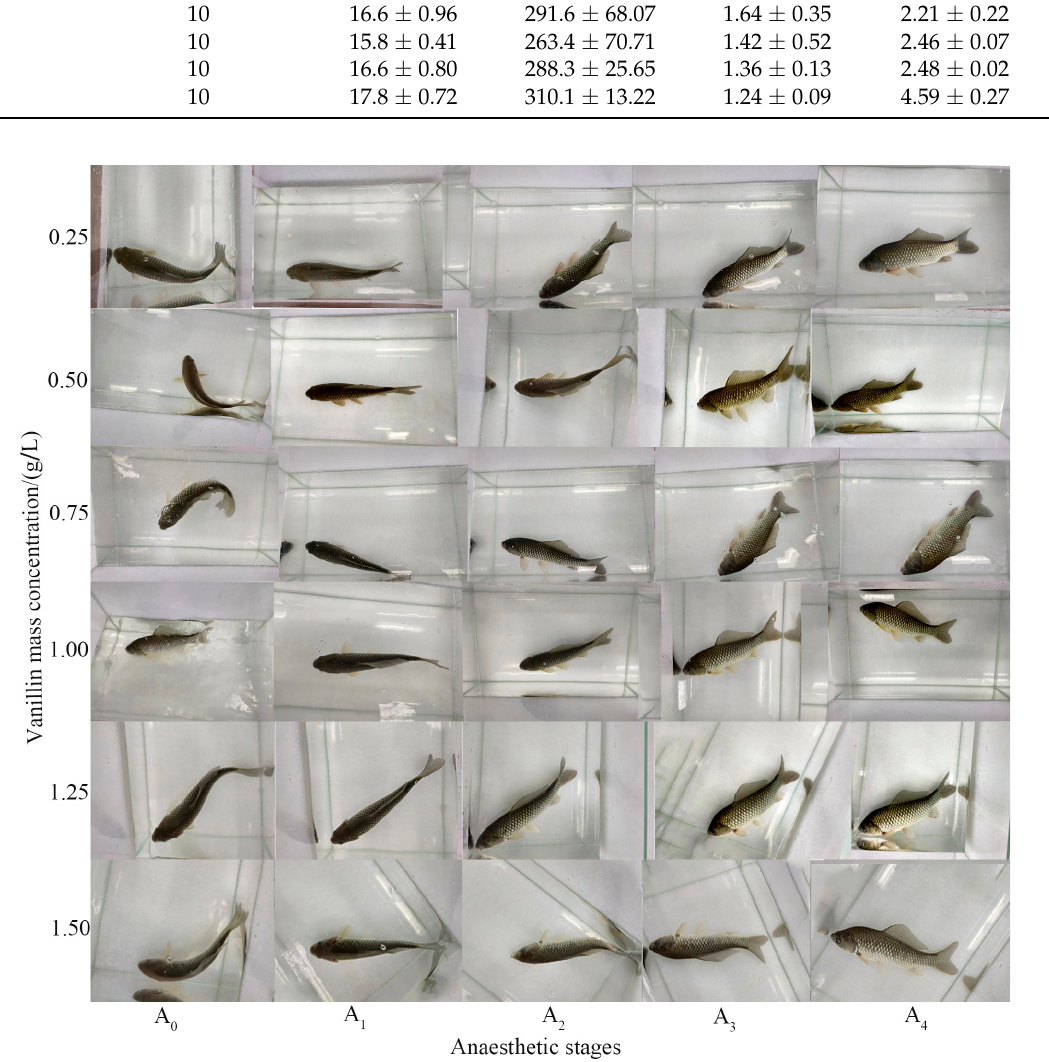
Figure 1. Appearance of crucian carp at the five stages of anaesthesia. Behavioural Characteristics of Crucian Carp during the Five Stages of Anaesthesia Onset and the Four Stages of Recovery The timing and behavioural characteristics at each stage of anaesthesia (A 0 –A 4 ) and recovery (R 1 –R 4 ) of crucian carp were determined using 1.00 g/L vanillin (Table 3). When a fish stopped swimming, completely lost the ability to respond, and the operculum opened weakly and slowly, it was defined as being at the A 3 stage of the anaesthesia period, and when the fish body was balanced and responsive, and the operculum opened normally, it was defined as being at the R 3 stage of